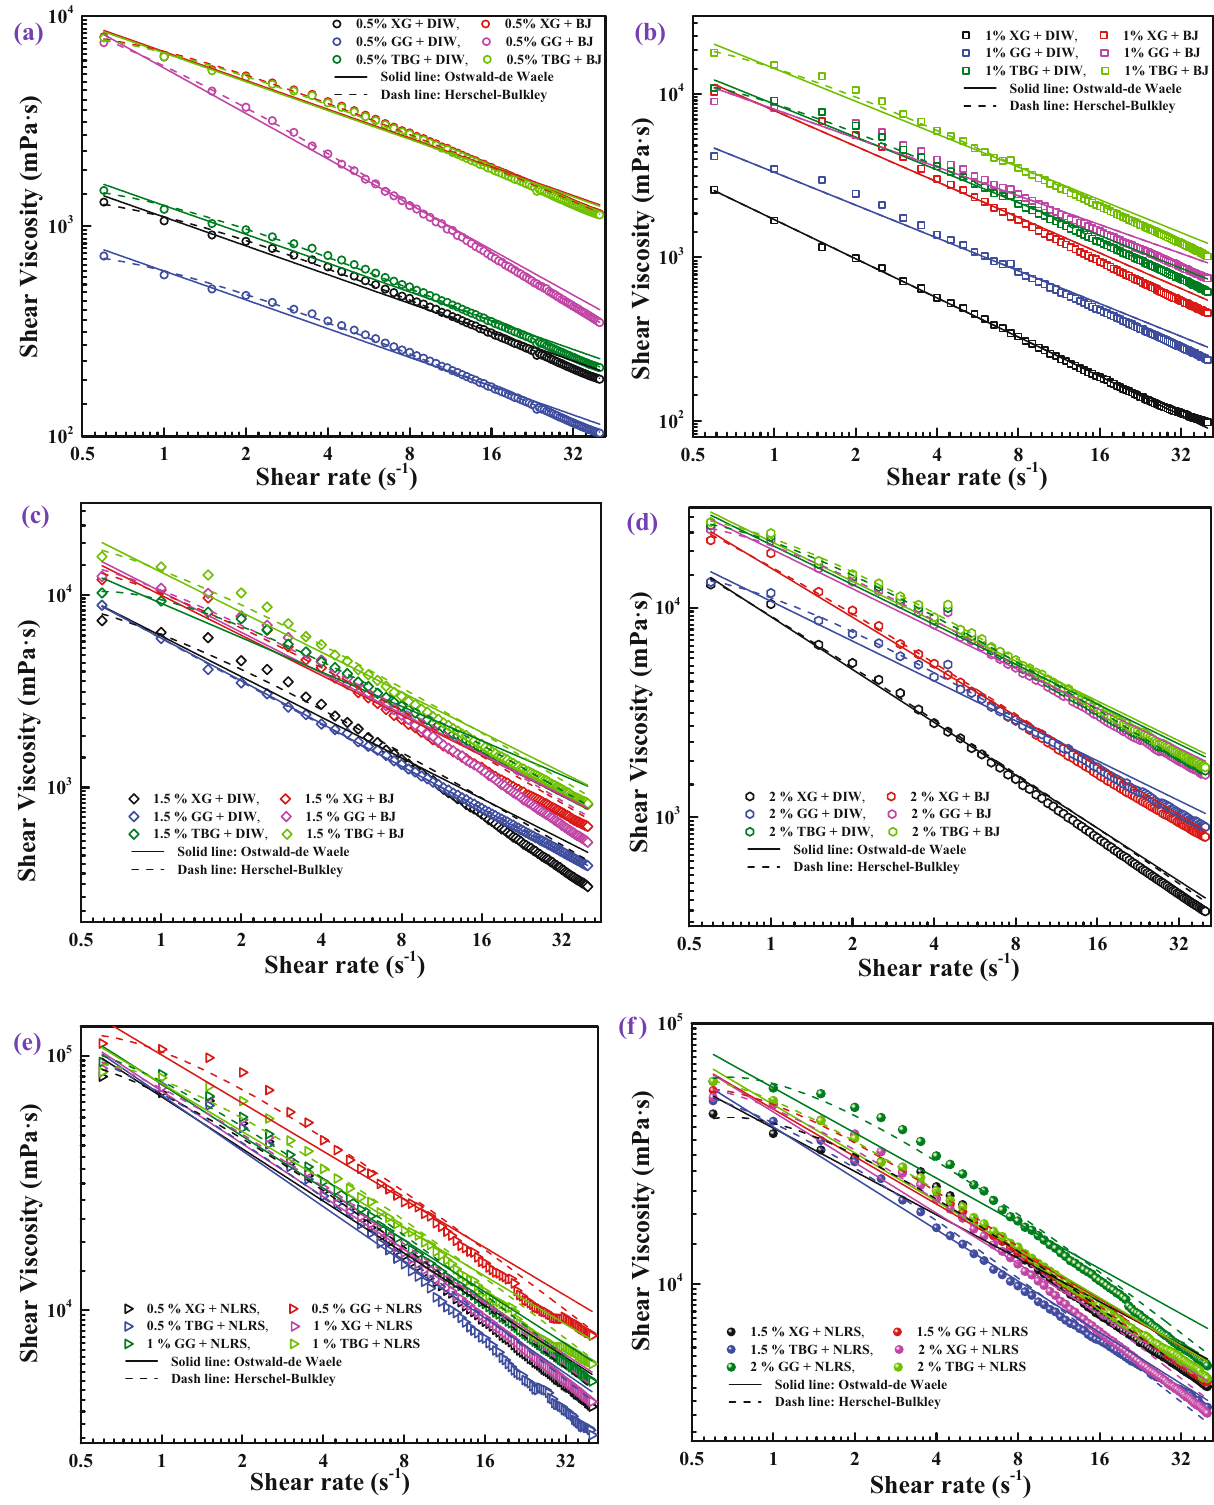
Figure 4: Room temperature ( 25 ± 0.5°C ) , thickening liquid shear viscosity, and shear rate. ( a ) 0.5% thickening gel dissolved in DIW and BJ, ( b ) 1% thickening gel dissolved in DIW and BJ, ( c ) 1.5% thickening gel dissolved in DIW and BJ, ( d ) 2% thickening gel dissolved in DIW and BJ, ( e ) 0.5% and 1% thickening gel dissolved in NLRS, ( f ) 1.5% and 2% thickening gel dissolved in